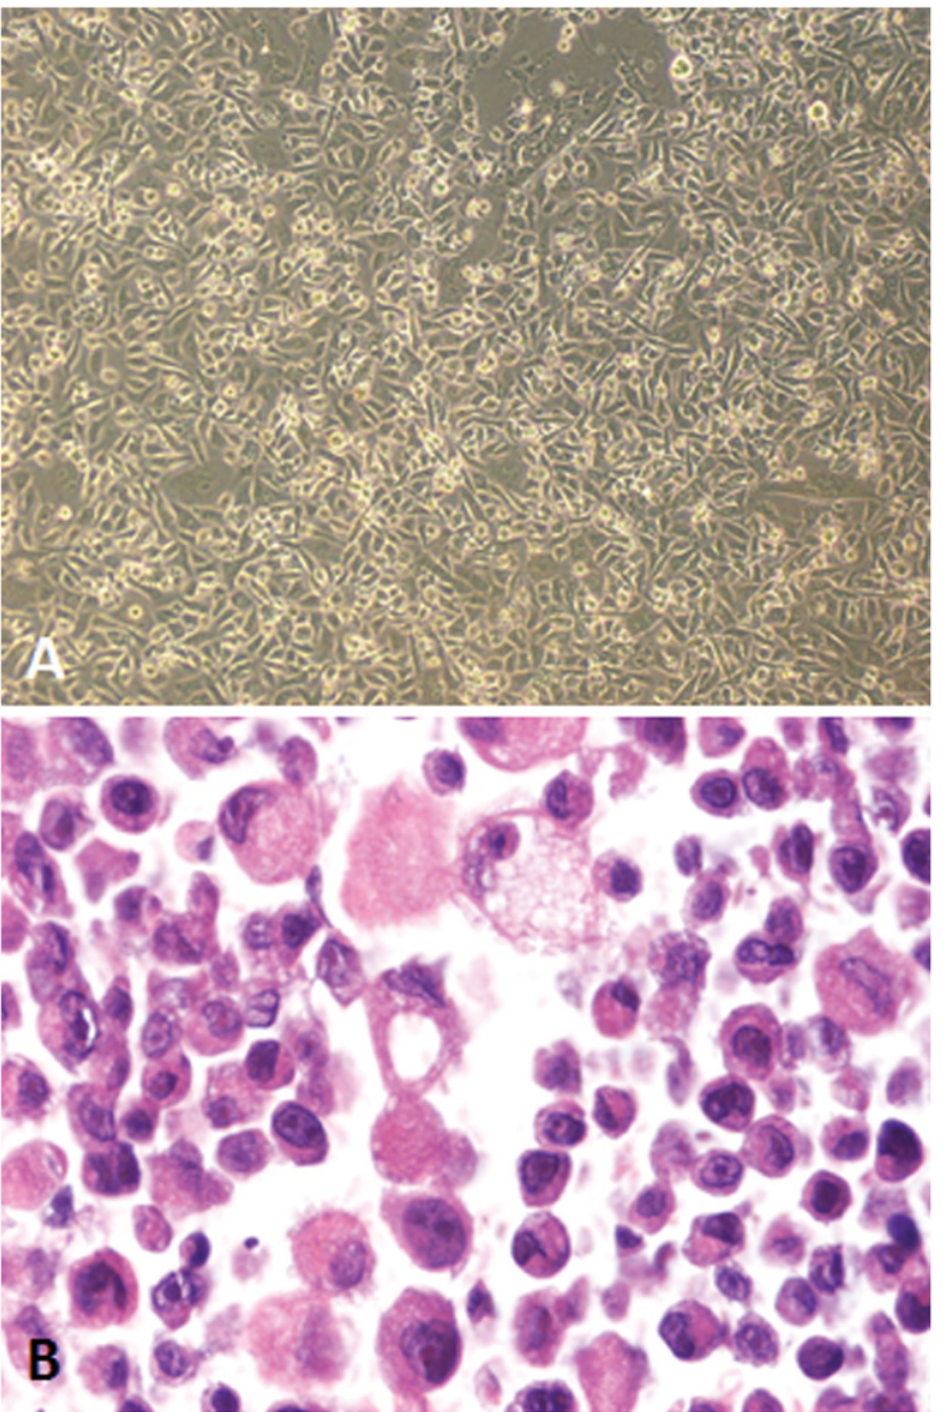
Fig 2. Morphology of IPC-366 cells. A) IPC-366 cells in culture at inverted microscopy (40X). B) IPC-366 pellet; paraffin section, H&E (40X). Highly malignant tumor cells with epithelial morphology; marked anisocytosis and anisokaryosis and evident nucleoli. Endothelial-like cell (ELC) showing cytoplasmic clear space (arrow). IPC-366 ultrastructural features were evaluated by electron microscopy. The cells had abundant cytoplasmic projections, numerous organelles and proteinaceous secretory products. By electron microscopy, the clear cytoplasmic vacuoles seen by optic microscopy, resulted empty spaces lined by cytoplasmic membranes that occasionally joined to form an internal lumen (ELCs, vasculogenic mimicry). (Fig. 3C-H).